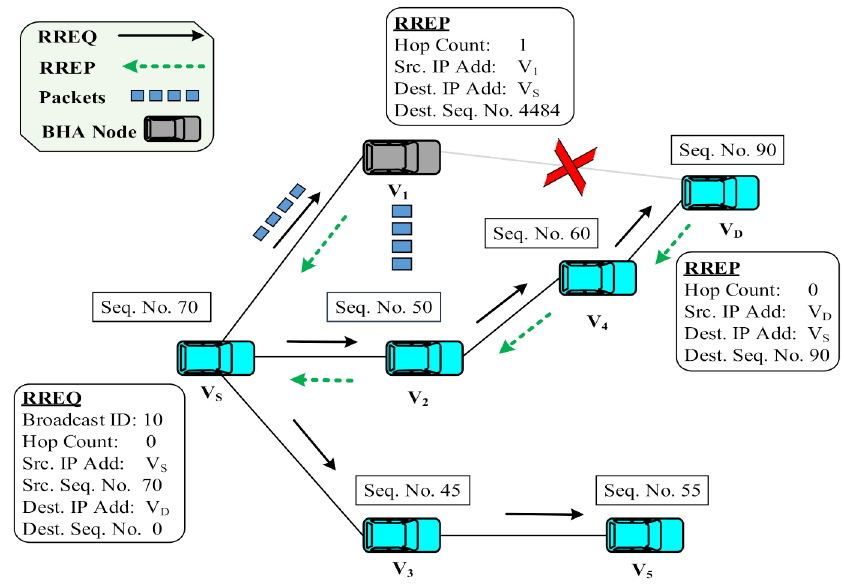
Figure 2. Black hole attack.